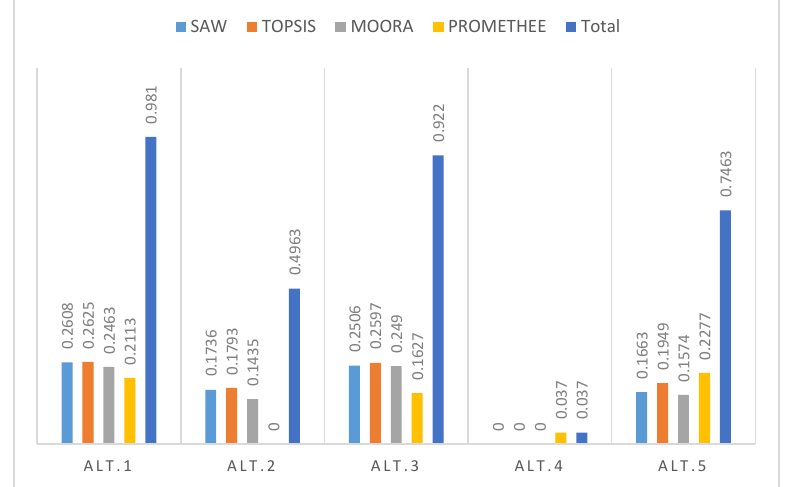
Figure 5. Merging the results of MADM methods following linear normalization.